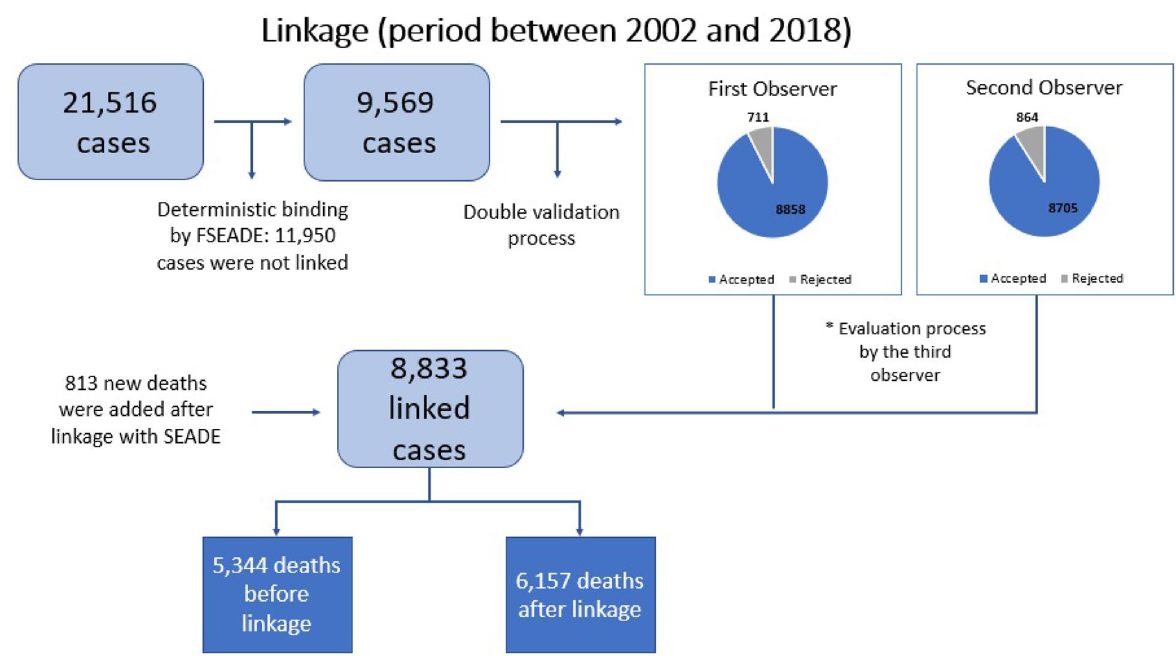
Figure 1. Flowchart with the steps performed in the first deterministic linking and the result of each